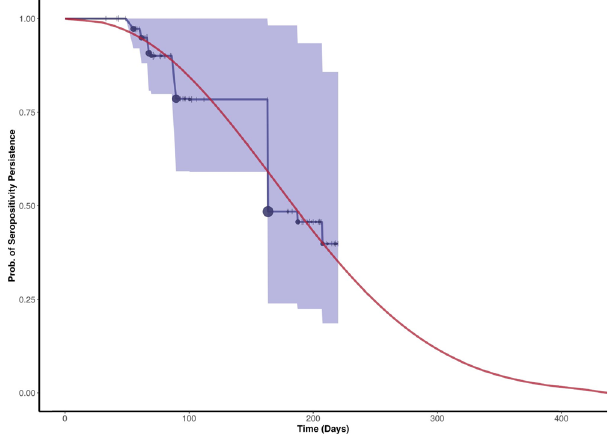
Fig. 5 Seroreversion data and model fi t. Persistence of seropositive test results with the Abbott assay among an extended cohort of 101 COVID-19 patients (extended dataset based from Muecksch et al. 25 ). The interval- censored Kaplan – Meier survival curve with 95% con fi dence intervals (blue) with censored observations (ticks) and seroreversion events (circles) is shown for comparison. Both censoring (range 1 – 4) and seroreversion events (range 0 – 16.16) are scaled according to the number of observations on the given day. The fi tted Weibull survival function (red) of persistence of a serologic positive result is shown in red. The fi t was estimated from symptom onset to time of seroreversion, where the time of seroreversion was estimated incorporating interval censoring. The mean time from symptom onset to seroreversion was 190.93